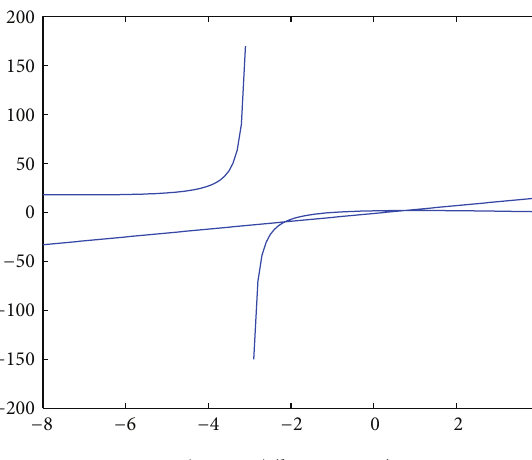
Figure 3: −(𝑐 − 𝑎𝑚 3 )/𝑏𝑚 3 > 0